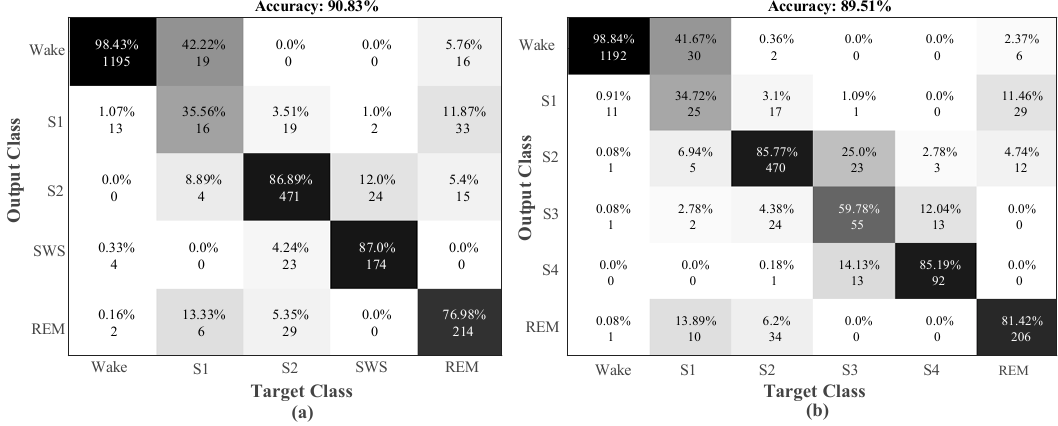
Figure 6. Performance graphs of the proposed 1D-CNN model with the single channel EOG signal for the sleep-edf dataset: ( a ) two-class model, ( b ) three-class model, ( c ) four-class model, ( d ) five-class model, ( e ) six-class model, and ( f ) validation accuracy for the models with two to six classes.